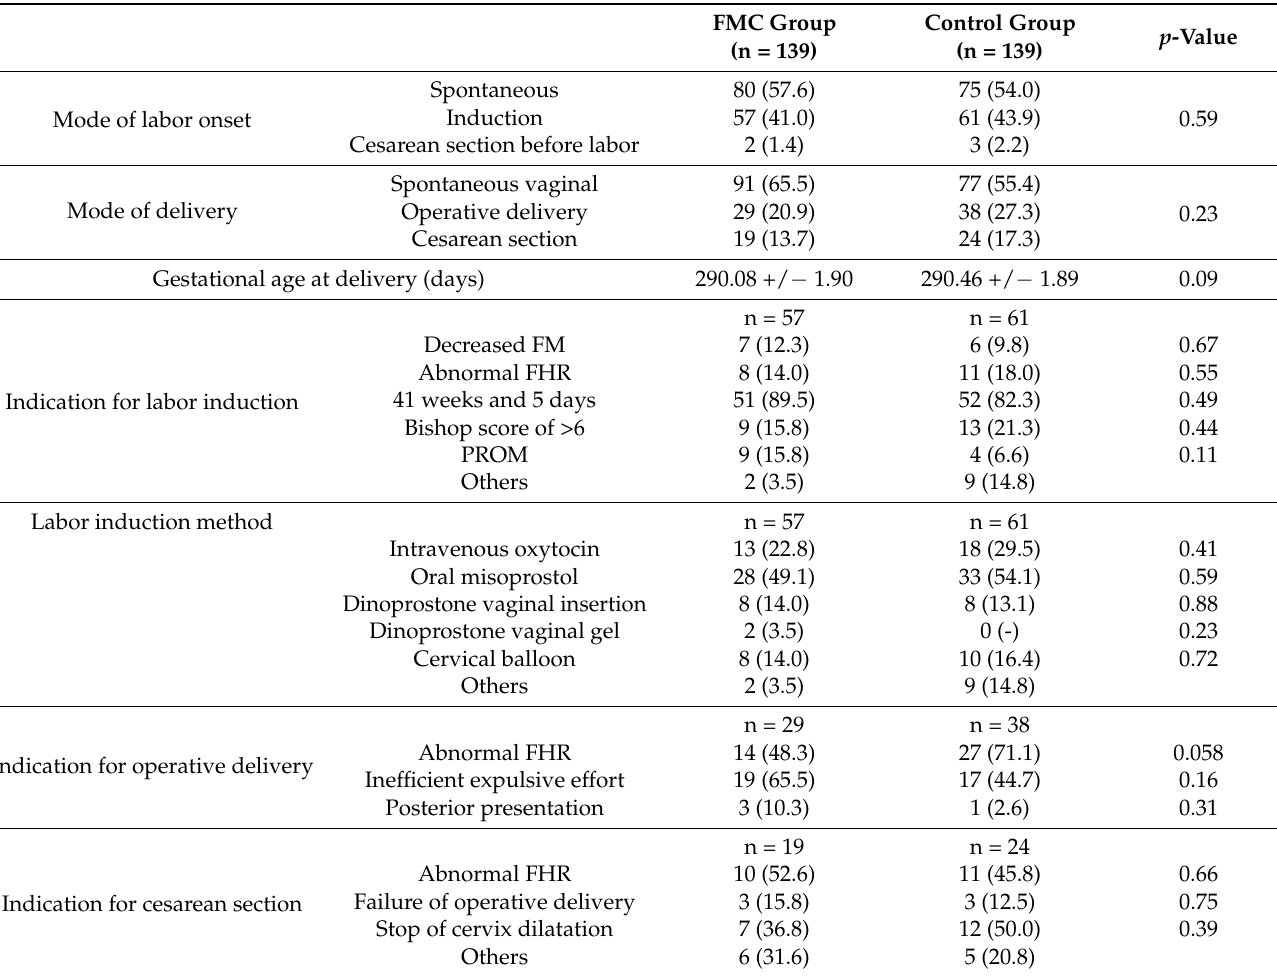
Table 4. Outcomes related to obstetrical management. Data are expressed as n (%) or means +/ − standard